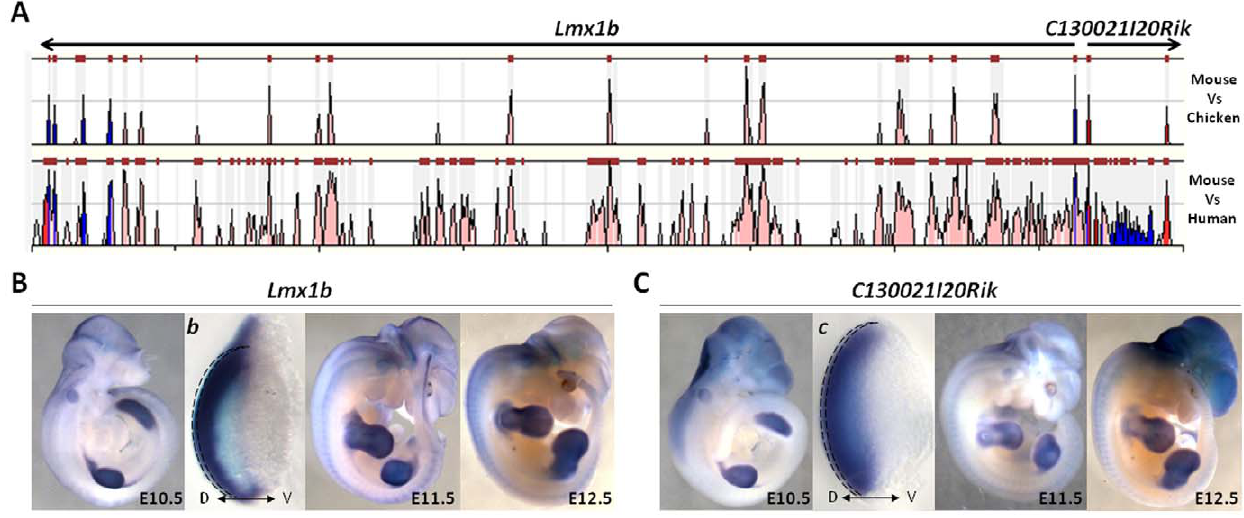
Figure 3. C130021I20Rik is a Novel Gene Co-transcribed from the Lmx1b Promoter, a well Known Limb Gene. C130021I20Rik was mapped to the Lmx1b gene locus (A) and found to be transcribed on the opposite strand. Time course in situ analysis revealed that C130021I20Rik (C) expression pattern is indistinguishable from its neighbor, Lmx1b (B), in the dorsal mesenchyme (b–c) suggesting that they are transcribed from the same divergent promoter and share limb-specific regulatory